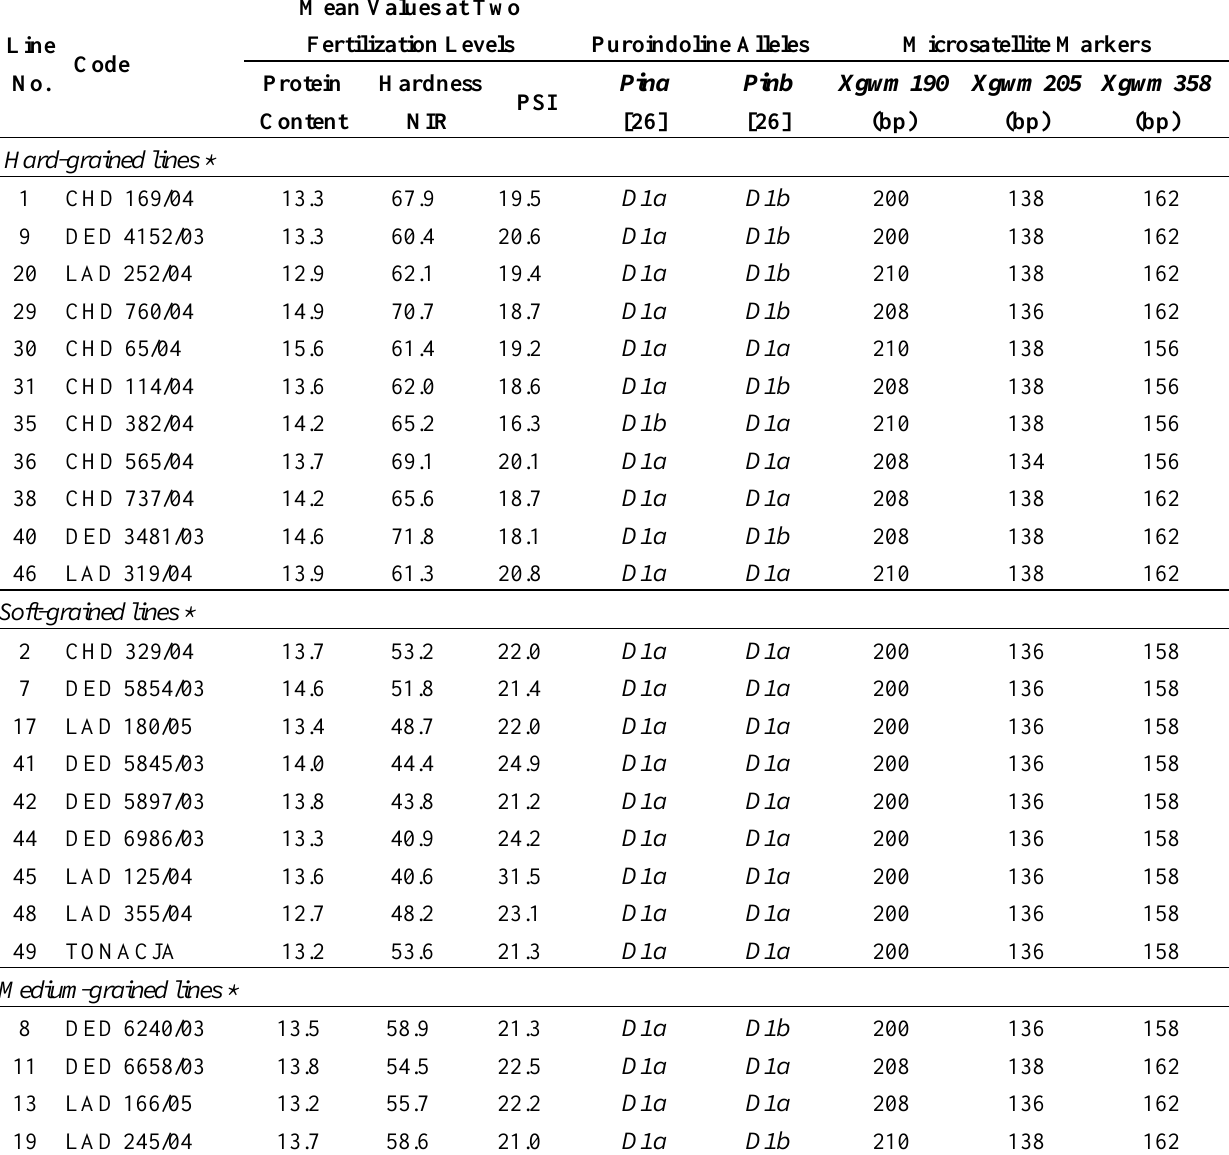
Table 1. Grain hardness, protein content and molecular characterization of studied winter wheat